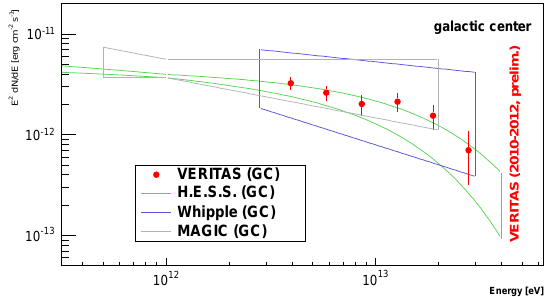
Figure 1: VERITAS energy spectrum measured from the direction of the GC (statistical errors only). Also shown are bow ties representing the spectra measured by Whipple [7], H.E.S.S. [8], and MAGIC [10].